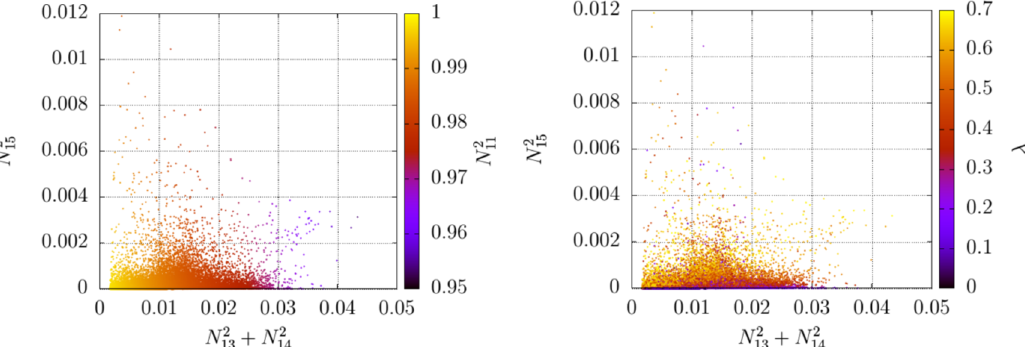
+ N 2 ) and the 13 14